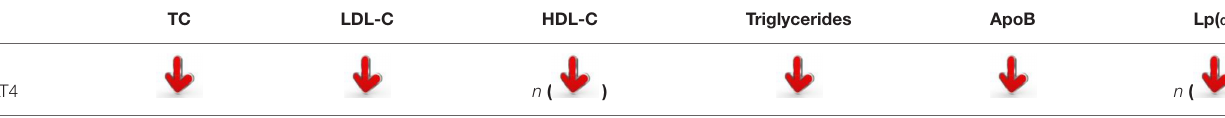
TC, Total Cholesterol; LDL-C, Low Density Lipoprotein Cholesterol; HDL-C, High Density Lipoprotein